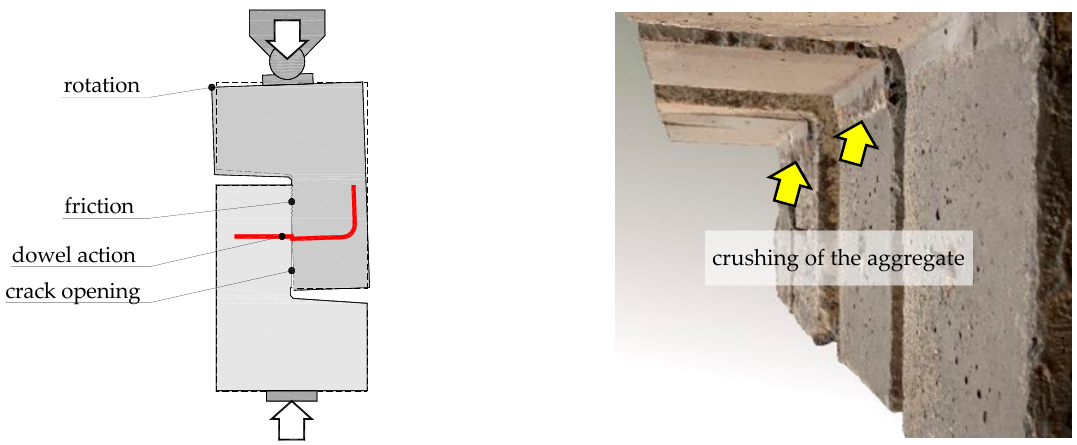
Figure 21. Frictional stress and aggregate crushing resulting from local pressure of the concrete block.